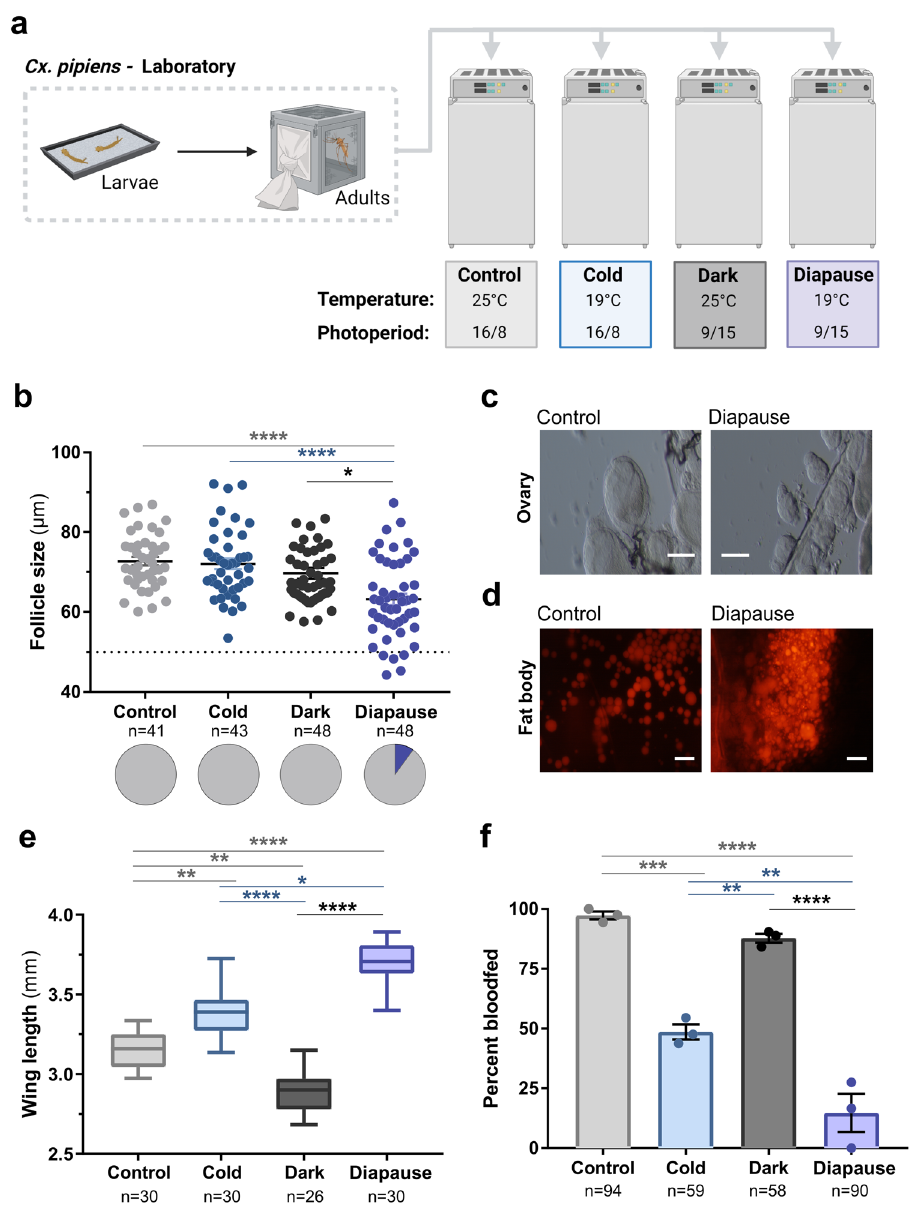
(Fig. 2b). Initially in 2020, groups of lab-reared fi rst-instar Cx. pipiens larvae were placed outside every 3 weeks from week 30 to week 39 (July to late September; Fig. 2b), with each group representing an approximate 1-h difference in photoperiod (Supplementary Fig. S3) ranging from ~15 to 12 h of daylight at